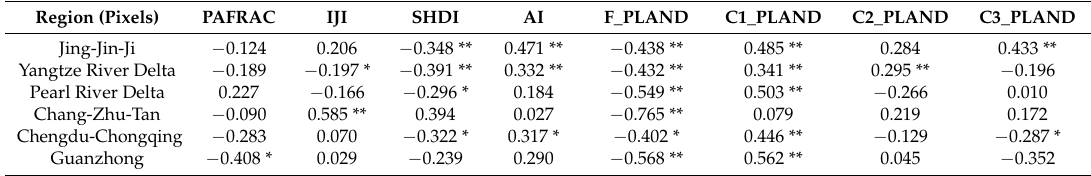
Table 3. Correlation between landscape with TSAM-based PM 2.5 at the pixels with in situ sites. Region (Pixels) PAFRAC IJI SHDI AI F_PLAND C1_PLAND C2_PLAND C3_PLAND Jing-Jin-Ji − 0.124 0.206 − 0.348 ** 0.471 ** − 0.438 ** 0.485 ** 0.284 0.433 ** Yangtze River Delta − 0.189 − 0.197 * − 0.391 ** 0.332 ** − 0.432 ** 0.341 ** 0.295 ** − 0.196 Pearl River Delta 0.227 − 0.166 − 0.296 * 0.184 − 0.549 ** 0.503 ** − 0.266 0.010 Chang-Zhu-Tan − 0.090 0.585 ** 0.394 0.027 − 0.765 ** 0.079 0.219 0.172 Chengdu-Chongqing − 0.283 0.070 − 0.322 * 0.317 * − 0.402 * 0.446 ** − 0.129 − 0.287 * Guanzhong − 0.408 * 0.029 − 0.239 0.290 − 0.568 ** 0.562 ** 0.045 −